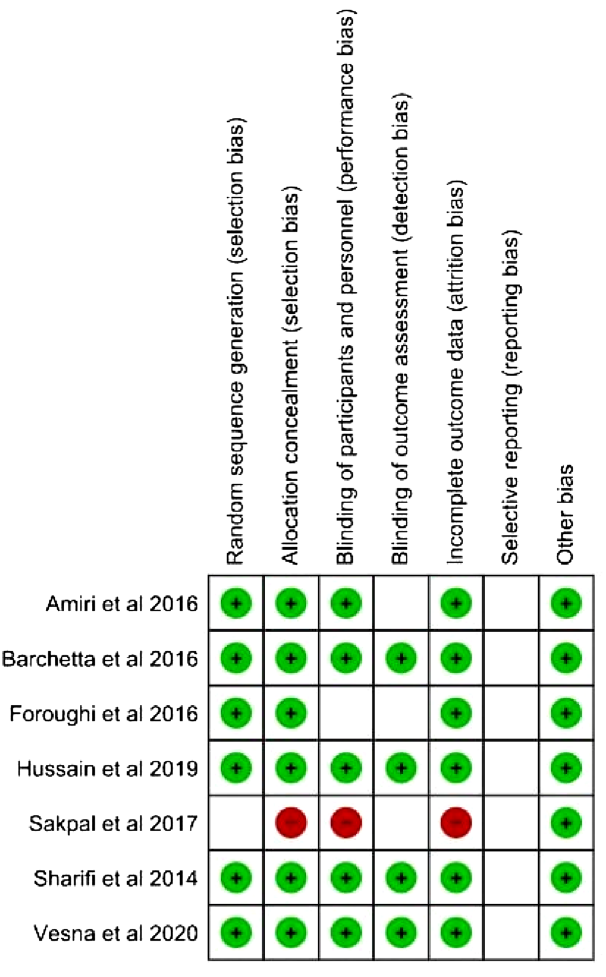
Figure 2. Risk of bias within studies.